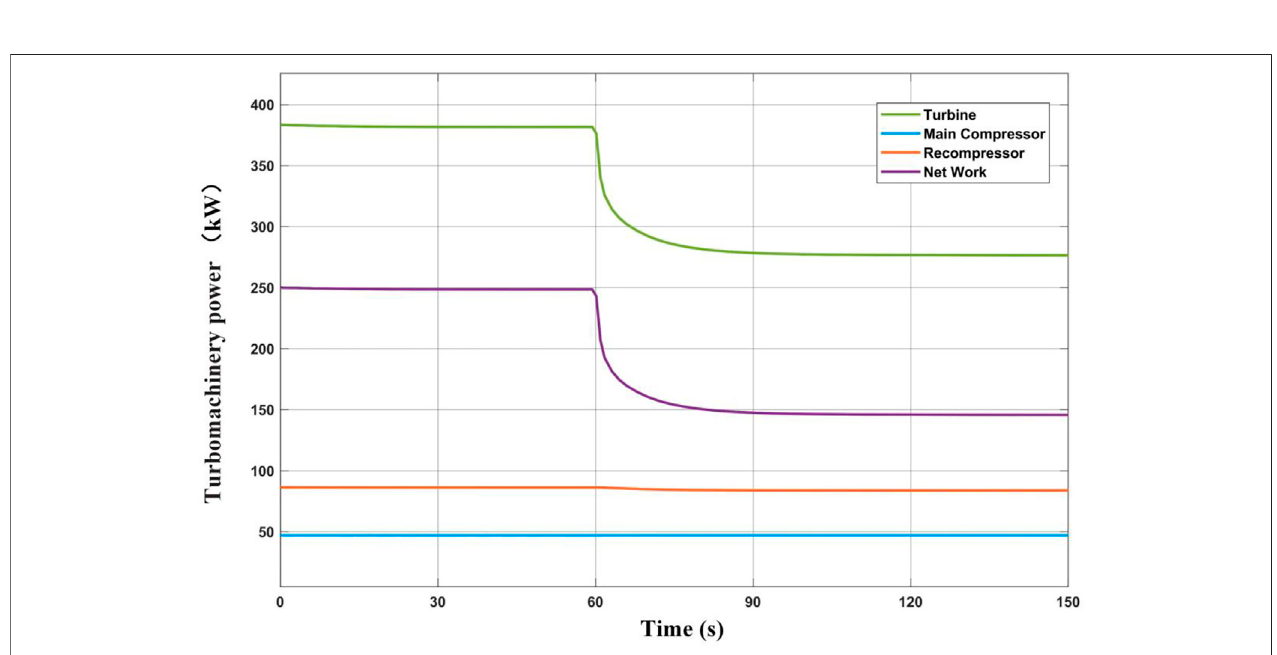
FIGURE 5 | Dynamic response of turbine machinery power while reducing heat source power.